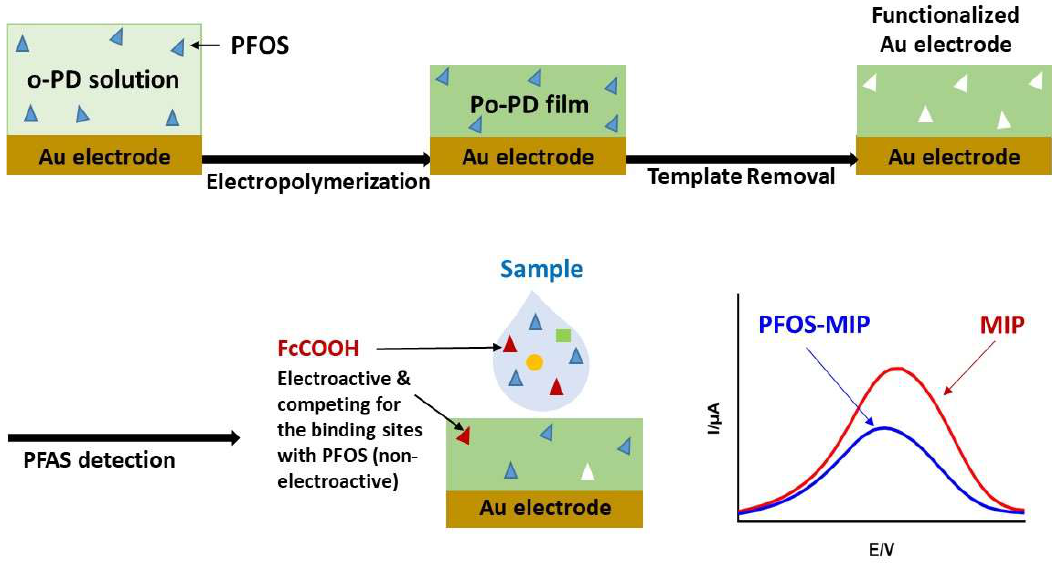
Figure 1. Schematic diagram of molecular imprinting and PFAS detection on a gold electrode. MIP: molecularly imprinted polymer, o-PD: ortho -phenylenediamine, Po-PD: poly( o -phenylenediamine). Adapted with permission from Karimian et al. [78].